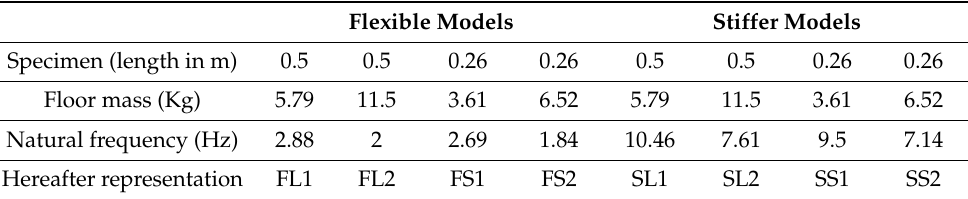
Figure 1. ( a ) Flexible models; ( b ) stiffer models. Table 1. The natural frequency of flexible and stiffer models.